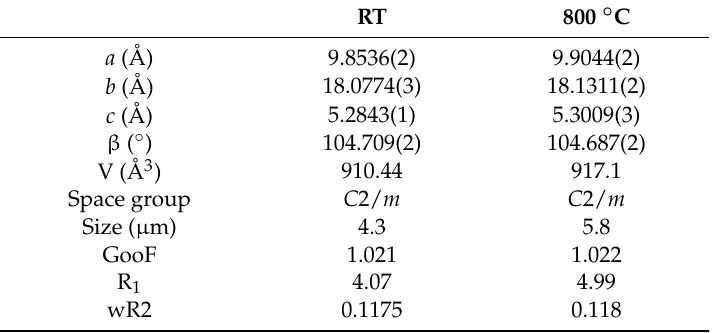
Table 1. Unit cell parameters and crystallographic details for the room temperature (RT) and 800 ◦ C tremolite